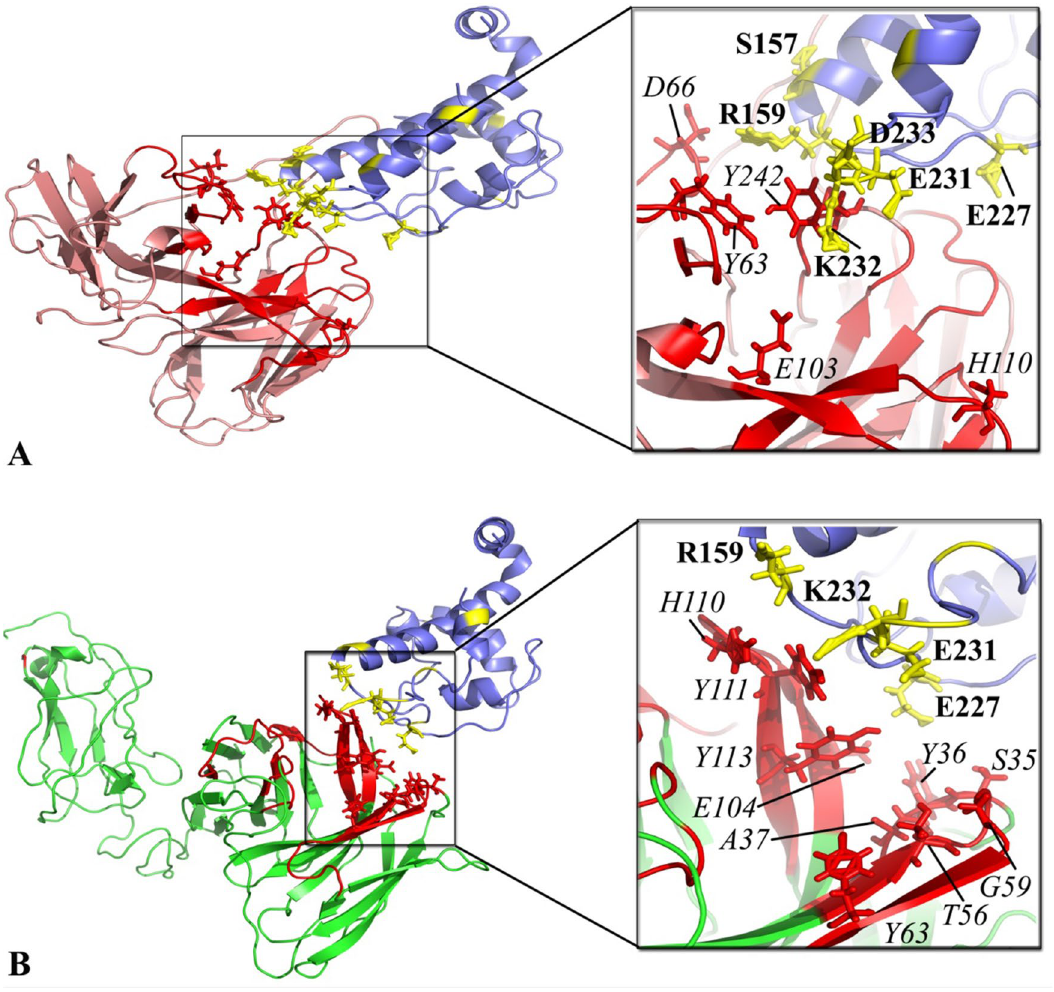
Figure 3. Molecular docking of scFv proteins towards PcrV: (A) YFL002/PcrV complex, (B) YFL001/PcrV complex. PcrV, YFL001, and YFL002 are shown in blue, green, and pink colors, respectively. CDRs of anti-PcrV molecules and binding residues of PcrV are in red and yellow, respectively. The interacting residues of YFL001, YFL002 and PcrV are in sticky format where YFL001 and YFL002 residues are italic and PcrV residues are